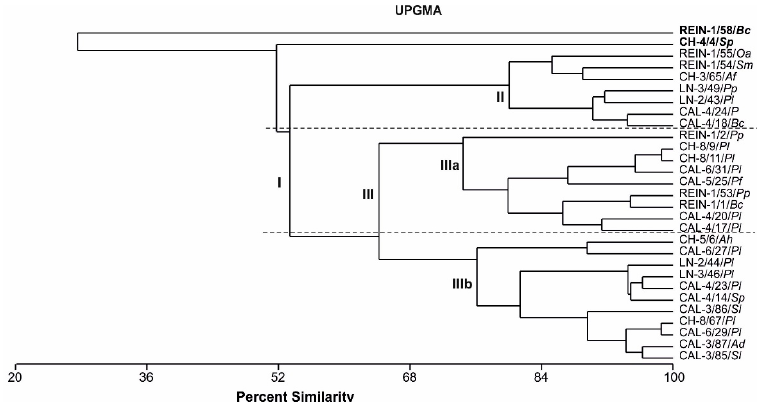
Figure 9. Dendrogram of the unweighted pair-group method with arithmetic mean (UPGMA) cluster analysis of 29 soil bacteria isolates, using a standardized percent similarity index. The analysis was performed on the basis of number of Copio and Oligo, SSB and PSB, AWCD index, DH activity, ACCD activity, IAA concentration with Trp0 and Trp500, and GI. For other abbreviations, please see Table